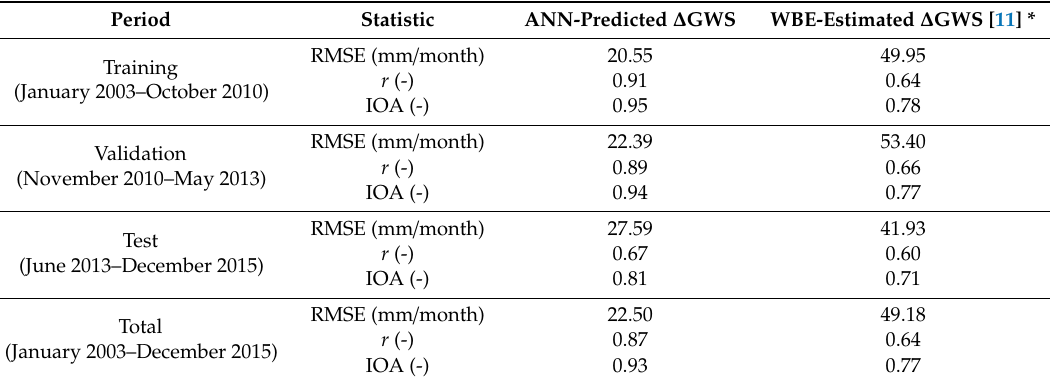
Table 2. Performance (root mean square error (RMSE), correlation coe ffi cient; r , and index of agreement (IOA)) of groundwater storage changes results compared to in situ